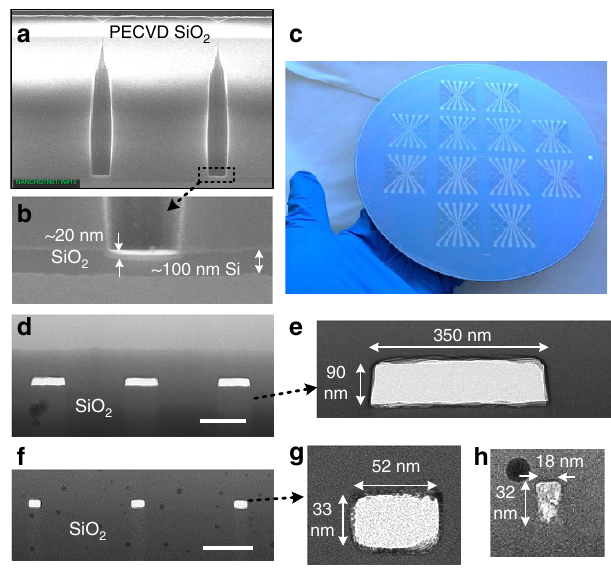
Figure 4 | Sacrificial nanofluidic devices after sealing venting holes. ( a , b ) Cross-sectional SEM images showing venting holes after PECVD SiO 2 sealing, showing: ( a ) completely sealed venting holes at the top surface; ( b ) only minimal ( B 20nm) SiO 2 deposited at the nanohole bottom. The a -Si layer was intentionally left to visualize the deposited SiO 2 . ( c ) Optical image of completed nanofluidic chips on an 8-inch wafer. ( d – h ) Cross-sectional TEM images showing different nanochannels dimensions: ( d , e ) 350nm by 90nm; ( f , g ) 52nm by 33nm; and ( h ) 18nm by 32nm. The scale bars in figures d and f are 500 and